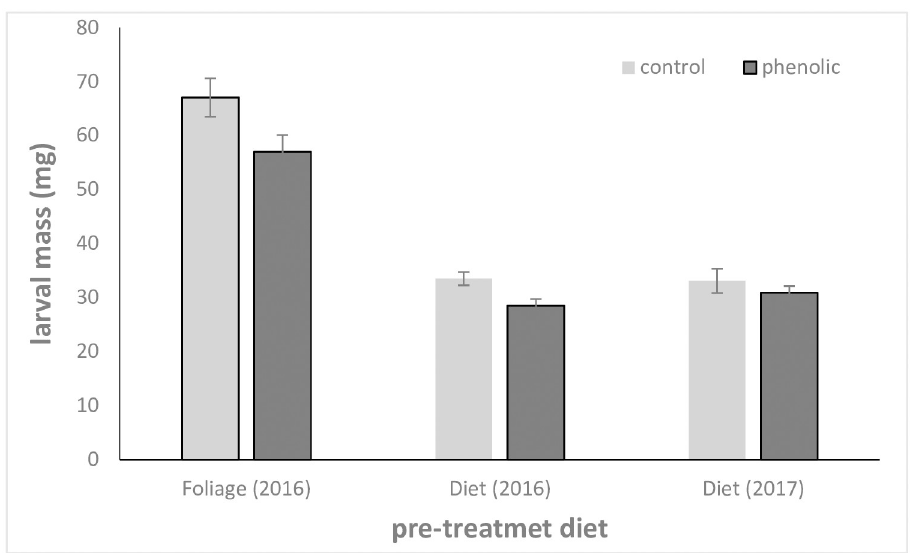
Fig 1. Budworm body mass. Body mass of sixth instar budworm caterpillars (mean ± SE, N = 50) fed on either control- or phenolic-laced artificial diet in the three experimental runs (pretreatment on foliage (2016) or on artificial diet (2016 &